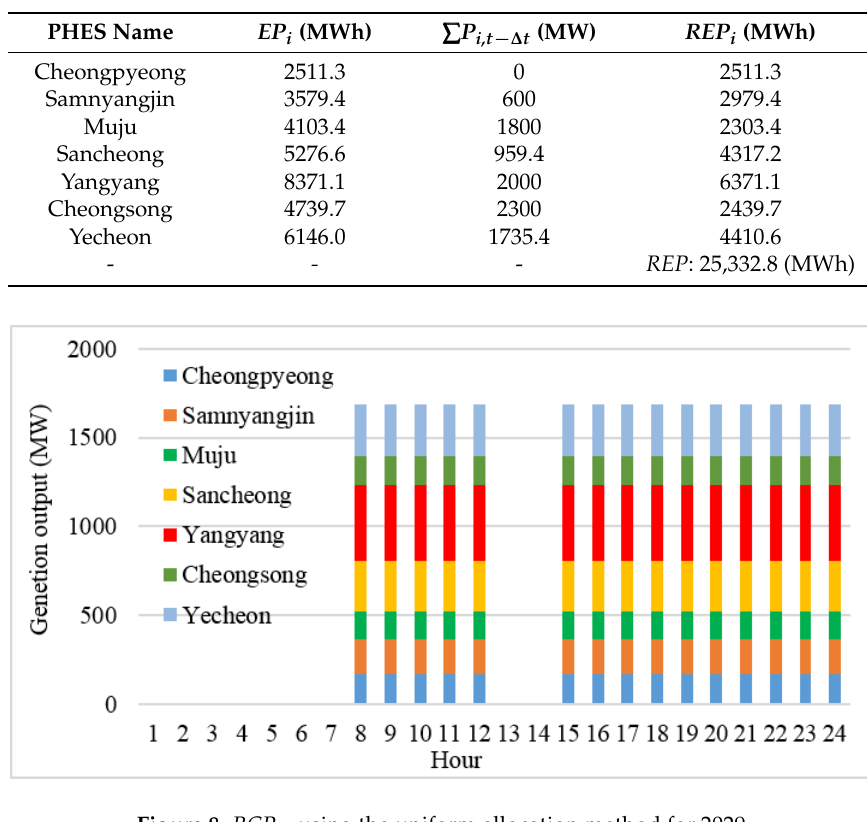
Figure 9. RSP t on the peak-load day in 2029.